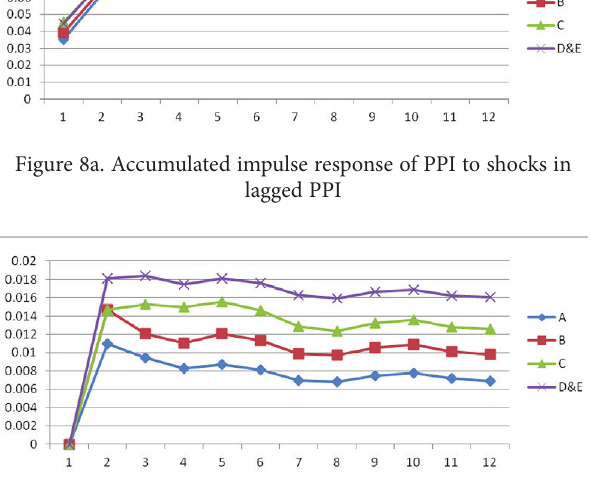
Figure 8b. Accumulated impulse response of PPI to shocks in